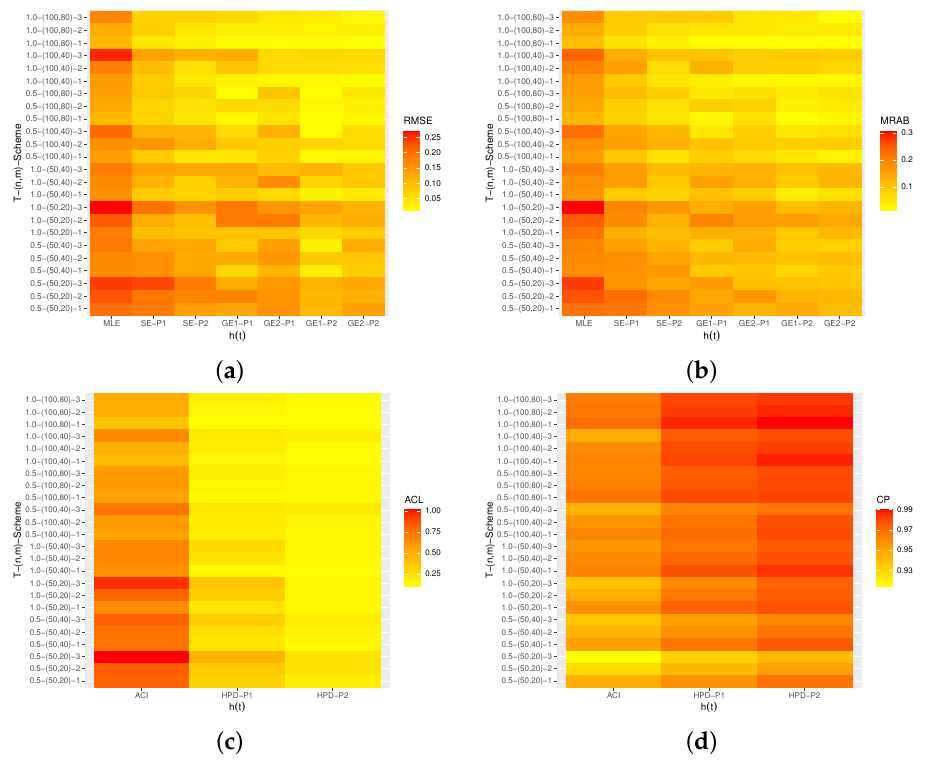
Figure 4. Heatmap plots for the estimation results of h ( t ) . ( a ) RMSE. ( b ) MRAB. ( c ) ACL. ( d )